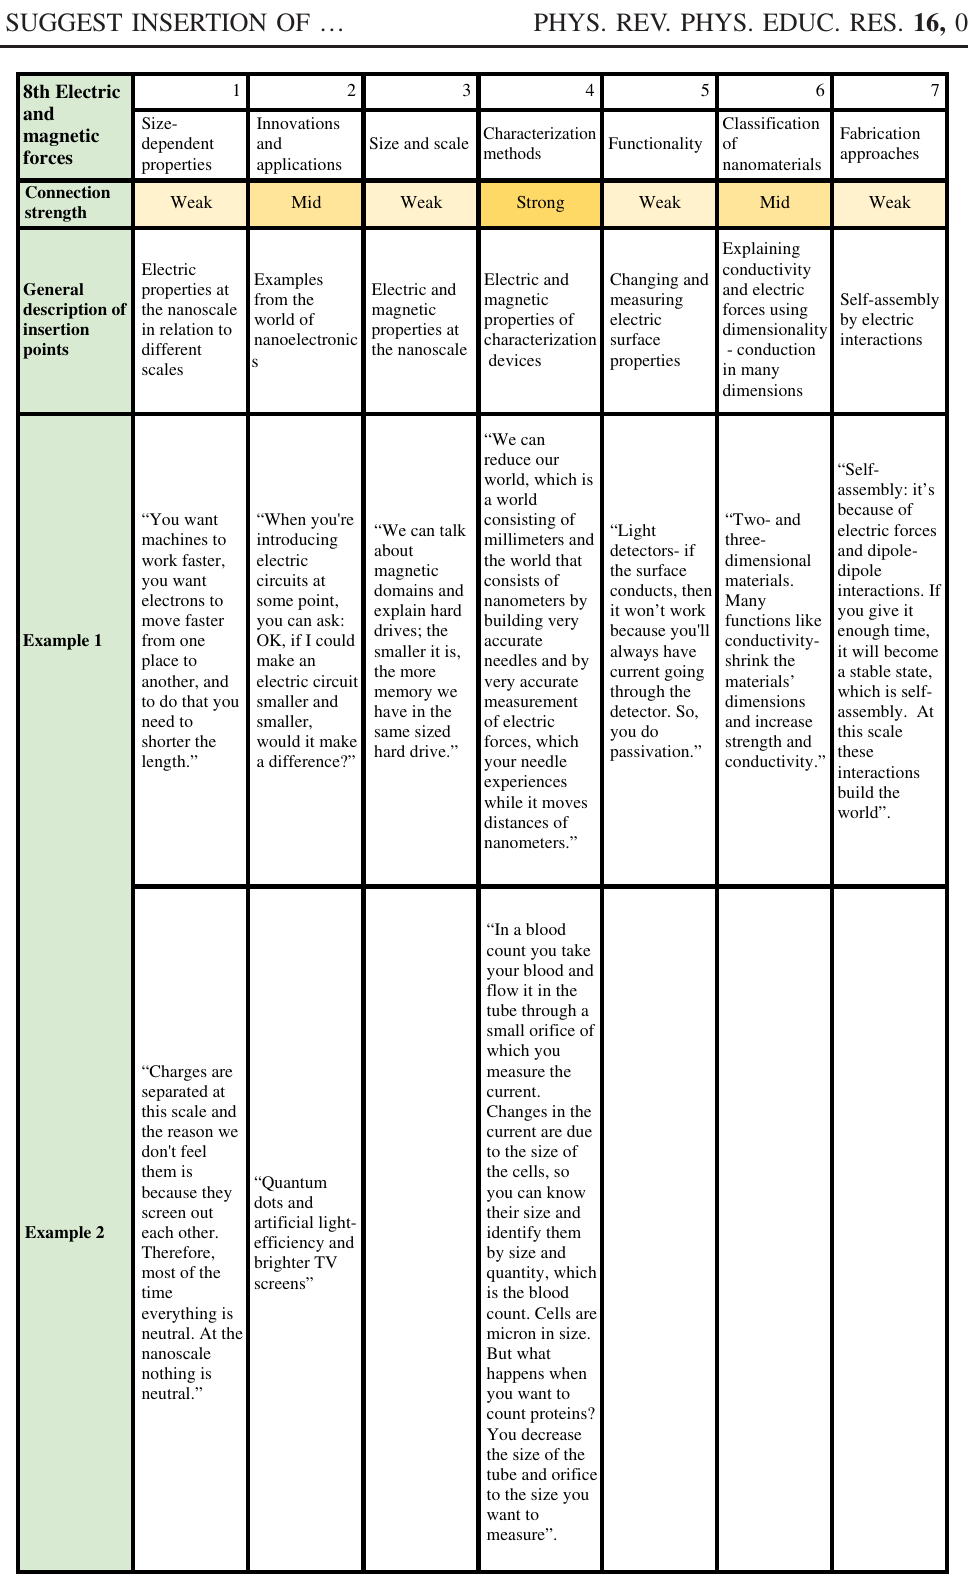
FIG. 5. A qualitative description of the NST context that was connected to a curricular topic by a concept with representative examples. Classification for “ weak, ” “ mid, ” and “ strong ” connections was made relative to the overall number of connections found for each topic (the numbers are presented in Fig. 4). For example, 31 connections were given for “ 8 electric and magnetic forces. ” There was an average of 4.42 connections per NST concept. If a concept received 4 or 5 connections (around the average), it was classified as “ mid ” . If it received less than 4, it was classified as “ weak, ” more than 5, as a “ strong ”